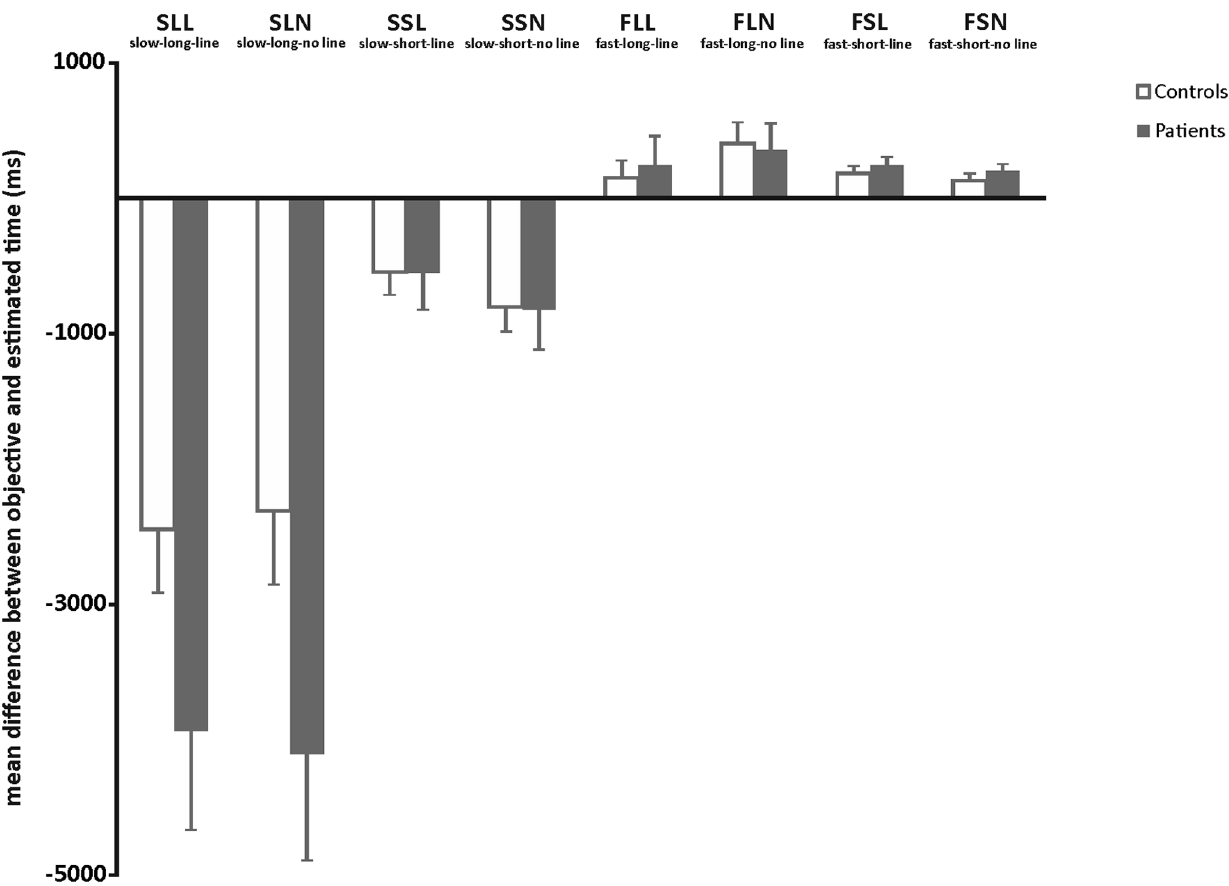
Figure 2. Mean AMT performance in patients and controls. Mean differences between objective and estimated movement time according to target speed (slow/fast), distance (short/long) and line (line/no line) for patients and controls. Positive scores indicate that movement time was overestimated; negative scores indicate that movement time was underestimated. Error bars represent the standard error of the mean.